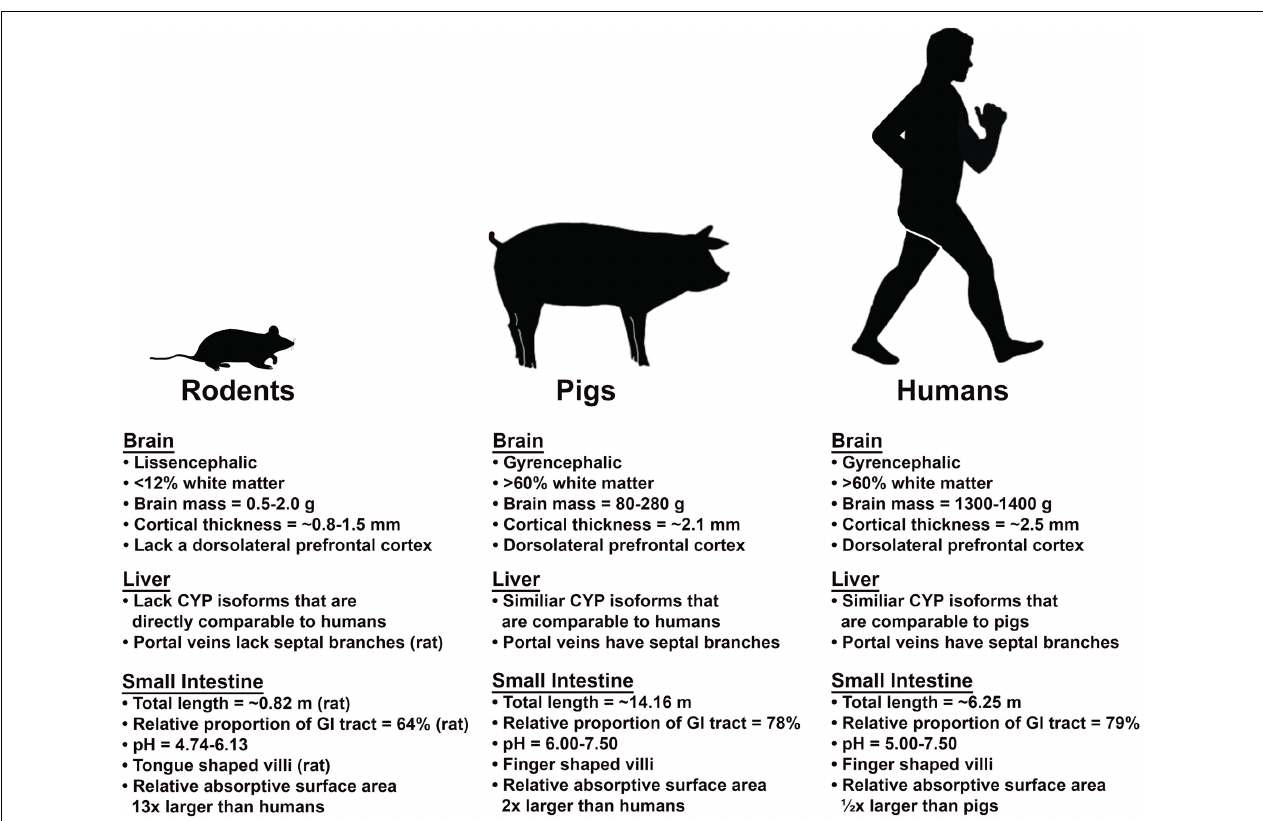
FIGURE 1 | Comparison of the brain, liver, and small intestine of rodent and pig models relative to humans. Pigs and humans share many similarities in brain, liver and small intestine that results in similar absorption, metabolism/excretion, and intoxication